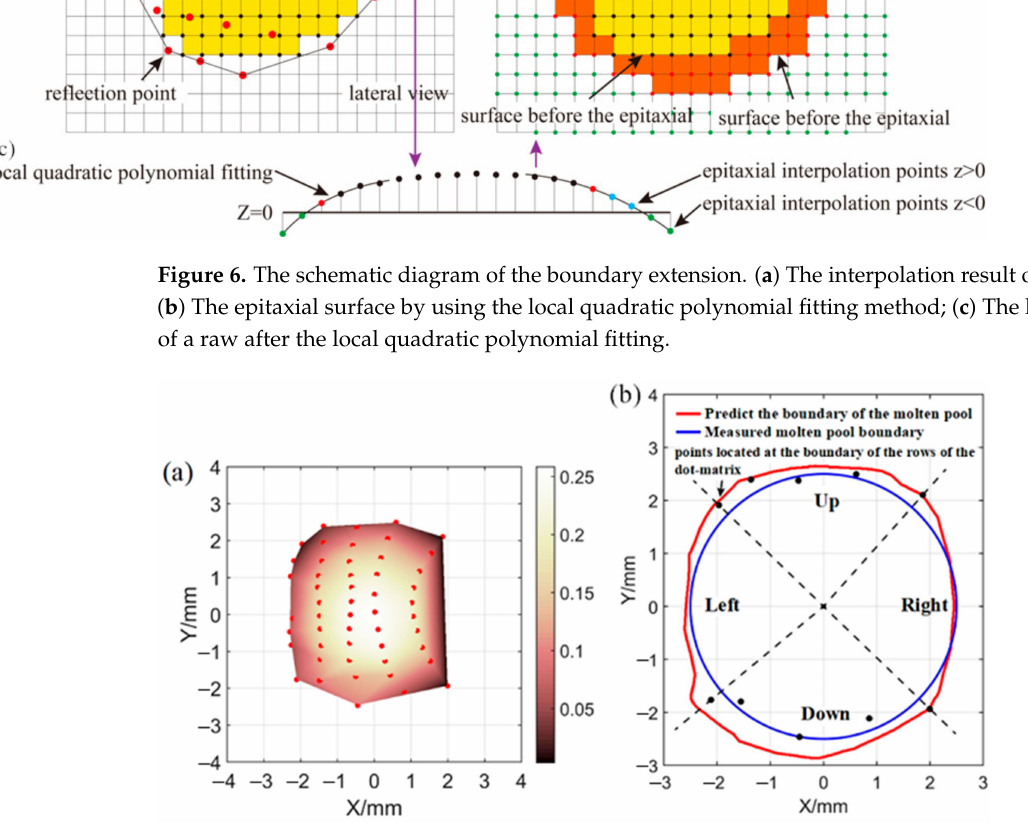
Figure 7. The extended results of the weld pool surface ( a ) The result of boundary extension; ( b ) the boundary comparison between the measured weld and the reconstructed weld pool surface.